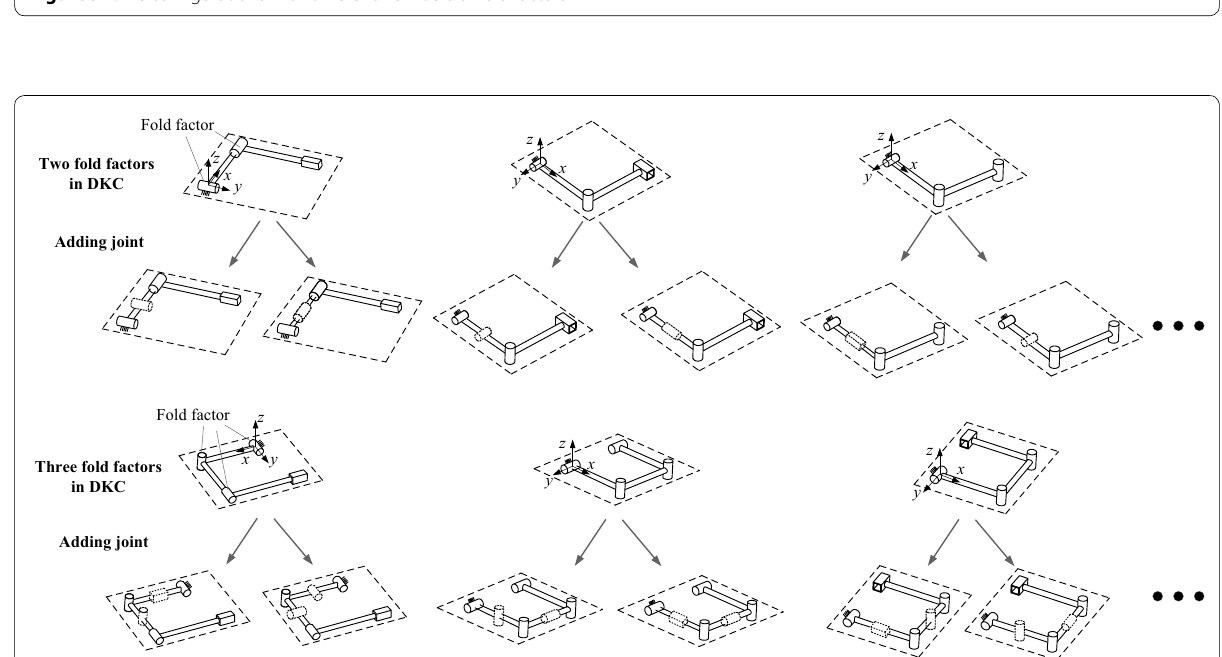
Figure 9 DKC configurations with different numbers of fold factors